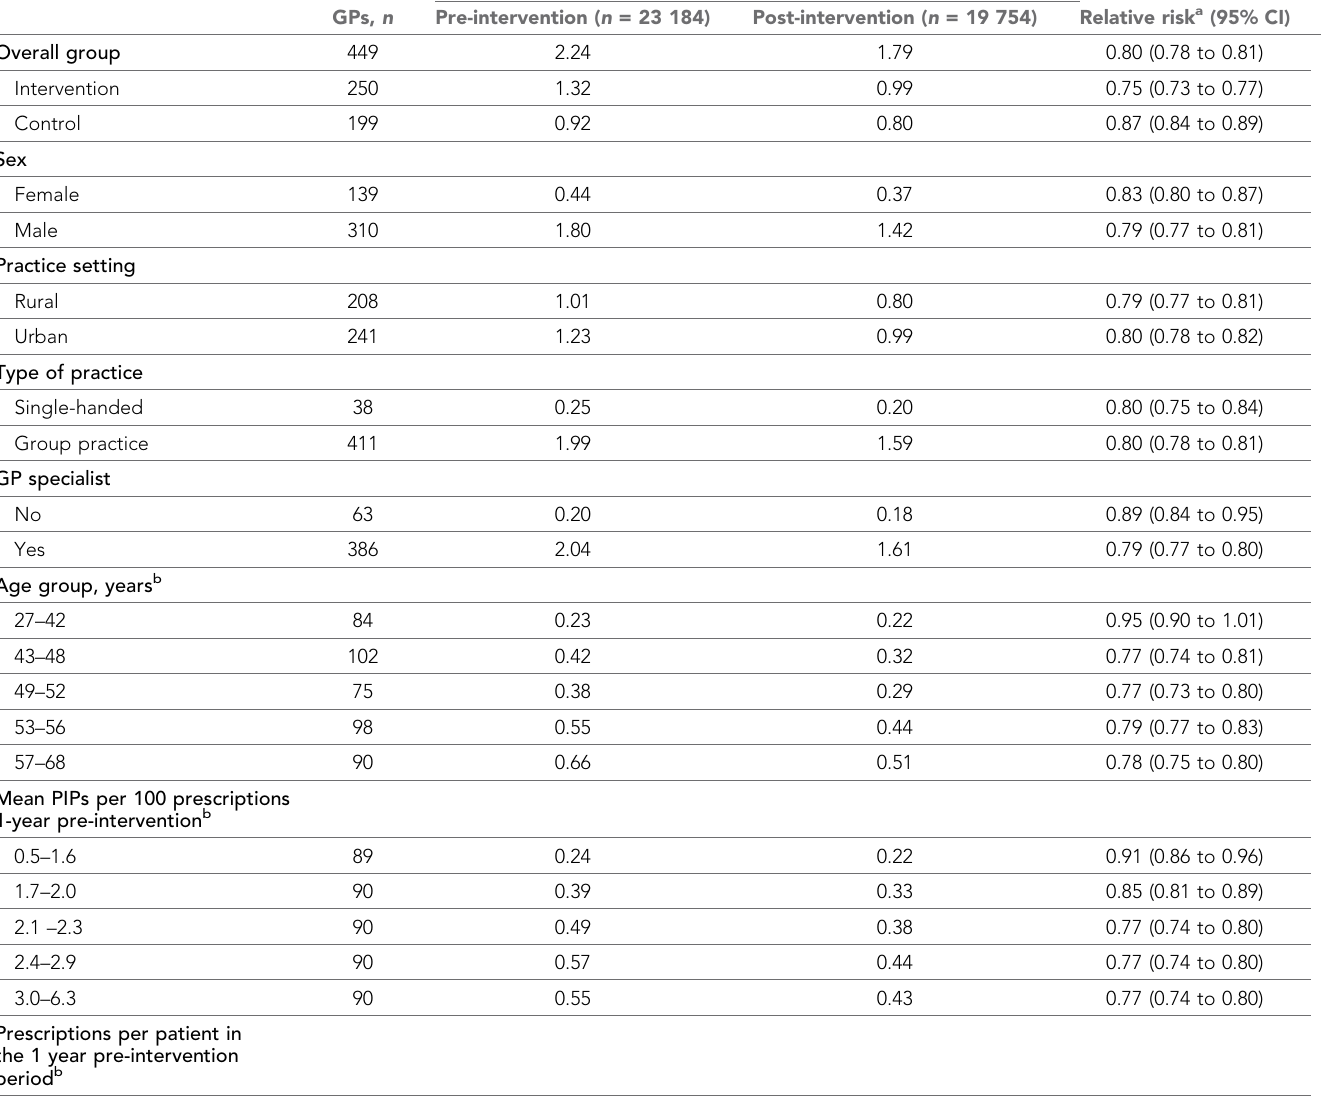
Table 1. Unadjusted summary data showing the prevalence of PIPs and estimates of RR with 95% CIs in different subgroups of GP and drug-related characteristics at pre- and post-intervention. The total number of prescriptions pre-intervention was 1 034 033 and in the post-intervention period there were 1 104 391